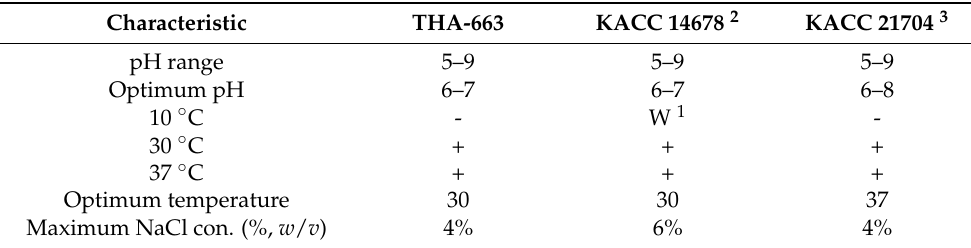
Table 1. Differences in pH, temperature and NaCl concentration.